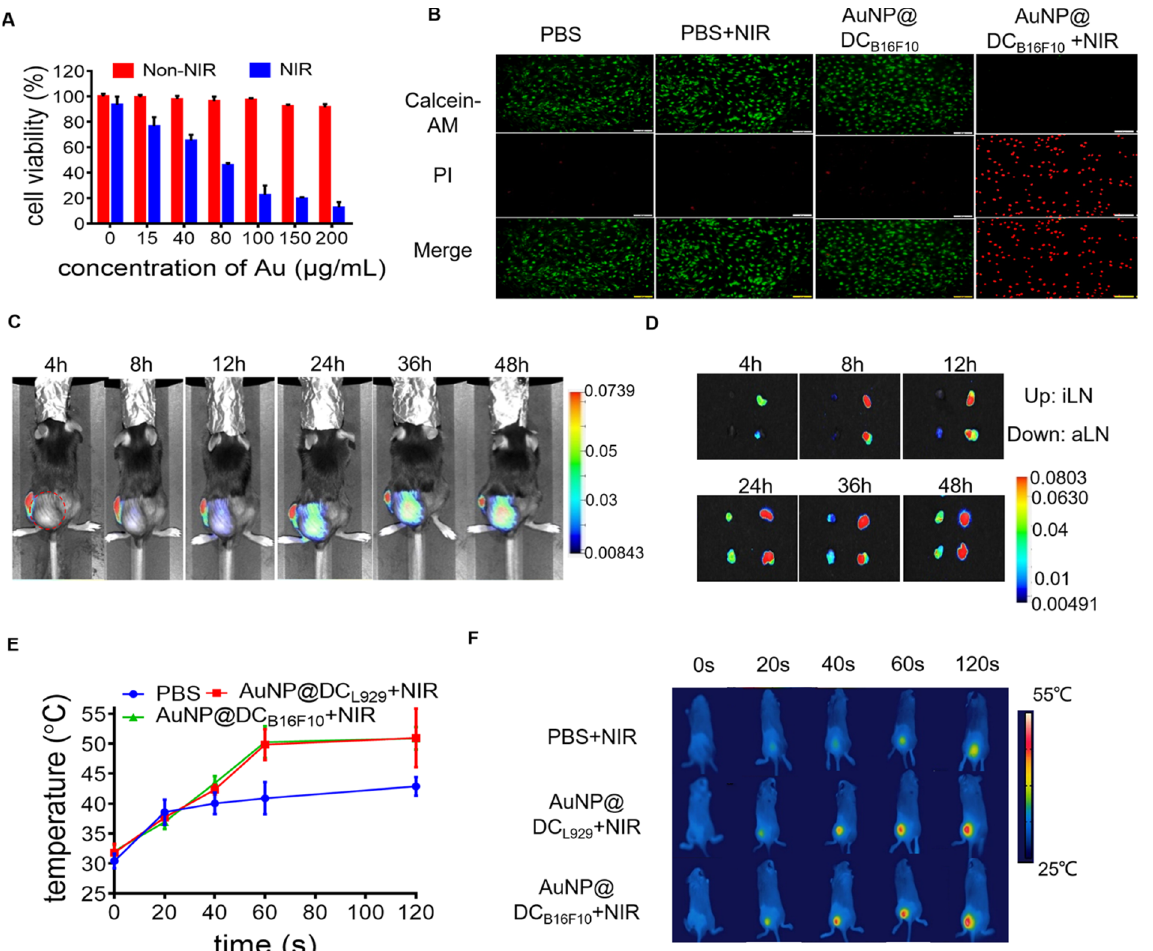
Figure 1. Cytotoxicity and characterization of AuNP@DCB16F10. ( A ) Cell viability of B16F10 cells treated with AuNP@DCB16F10 after incubation for 24 h. ( B ) Cytotoxicity images of B16F10 cells. ( C ) In vivo distribution of AuNP@DCB16F10 labeled by DiR in tumor-containing mice. ( D ) Lumines- cence images of nanoparticle migration. ( E , F ) Infrared thermal images and temperature profiles of tumor-containing mice with injection of PBS, AuNP@DCL929, and AuNP@DCB16F10. Reprinted with permission from [34]. Copyright 2019, American Chemical Society.